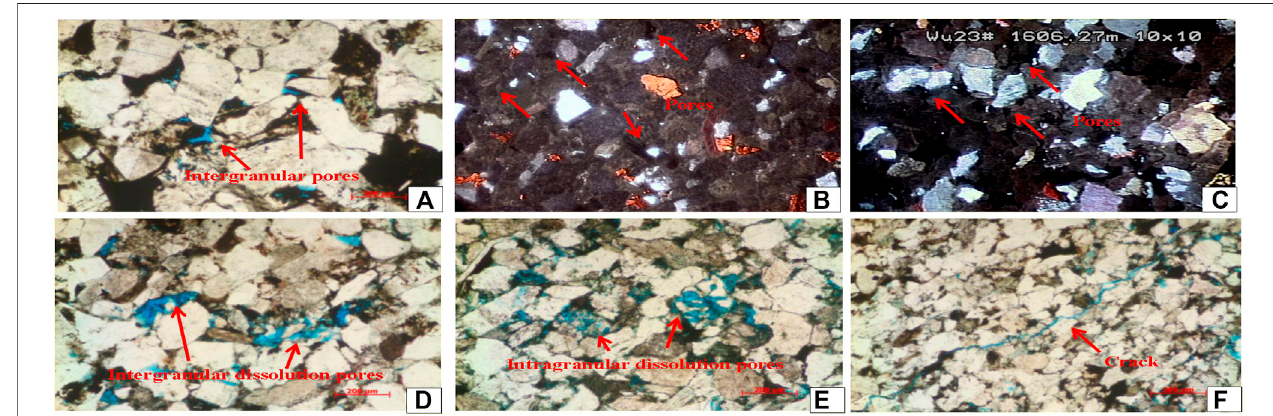
FIGURE13| Reservoirspacecausedbygravity fl owundermicroscopeandcathodoluminescence.See Figure2 forthelocationofwells. (A) Residualintergranular pores can be seen among the quartz grains, well Cai12, depth 2000.8 m; (B) Cathodoluminescence; visible calcite (orange, yellow) and dolomite (orange) cementation; clastics are interlocked; and pores are not luminescence. Well Zhuang70, depth 1735.35 m; (C) Cathodoluminescence; fi ne-grained feldspar sandstone; feldspar content between 55 – 60%. Well Wu23, depth 1,606.27 m; (D) Intergranular dissolution reaming is developed. Well Li183, depth 2068.3 m; (E) Intragranular dissolution pores of feldspar are developed. Well Li183, depth 2,105.8 m; (F) Structural micro-cracks. Well Li312 , depth 2087.6 m.